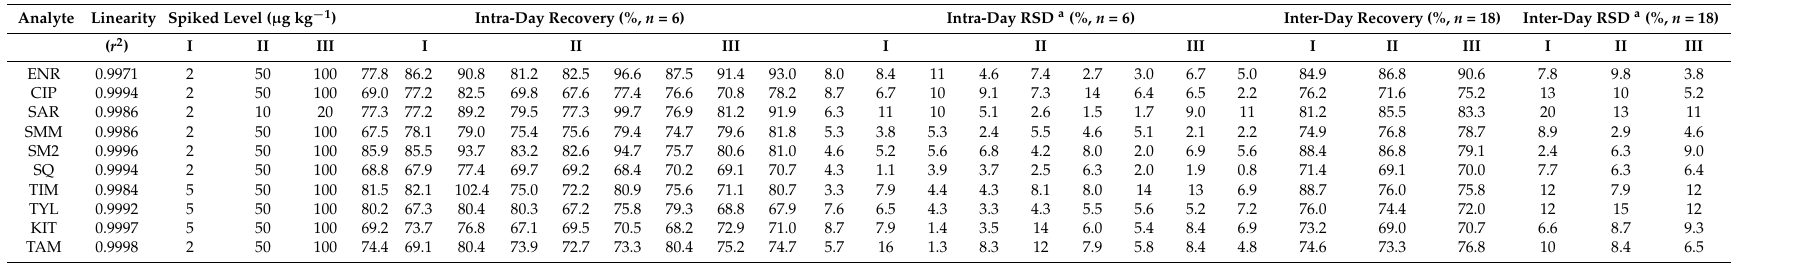
Table 2. Linearity, recovery, and precision for the method in the chicken muscle